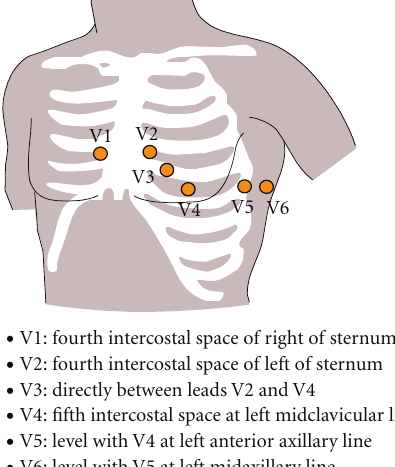
Figure 6: A comfortable halter covers V1 to V6 with nano-grid dry